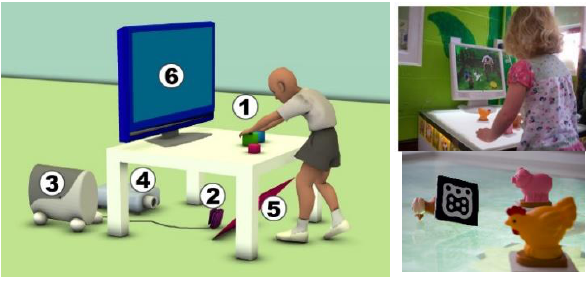
Figure 1. NIKVision sketched